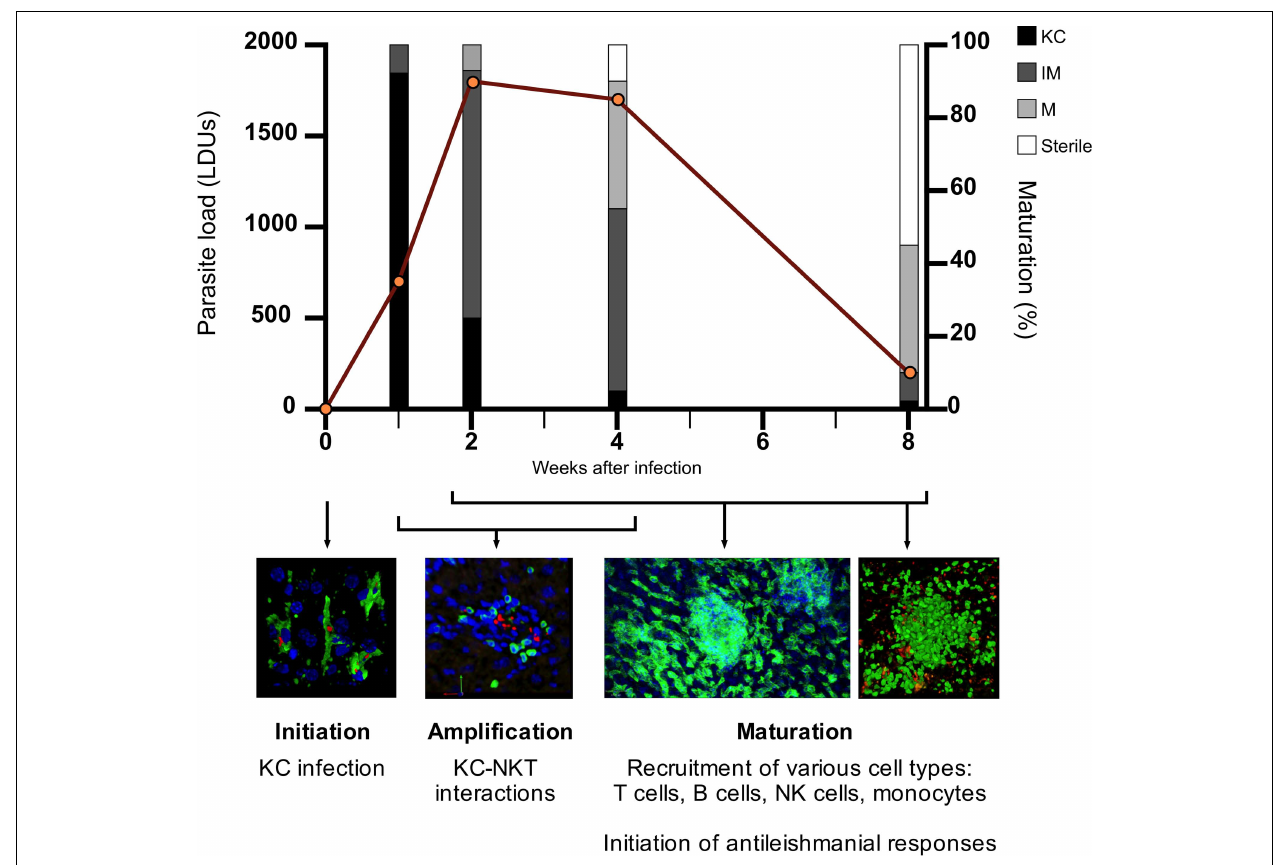
stage, the inflammatory response peaks around 4 weeks p.i. where the antileishmanial response becomes sufficient to begin clearing the parasite burden. As parasites are cleared from individual infected KC foci, cells begin to move out of the granuloma, returning the liver to its original pre-infection state. Hepatic granulomatous inflammation resolves by 8 weeks p.i. with the majority of parasites cleared. Data on parasite load and granuloma maturation redrawn from Murray (2001). KC, Kupffer cell; IM, immature granuloma; M, mature granuloma; sterile, sterile